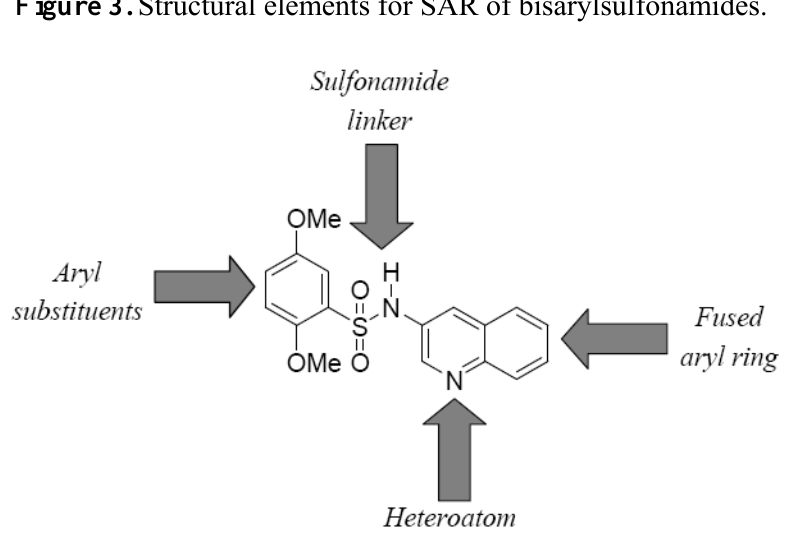
Figure 3. Structural elements for SAR of